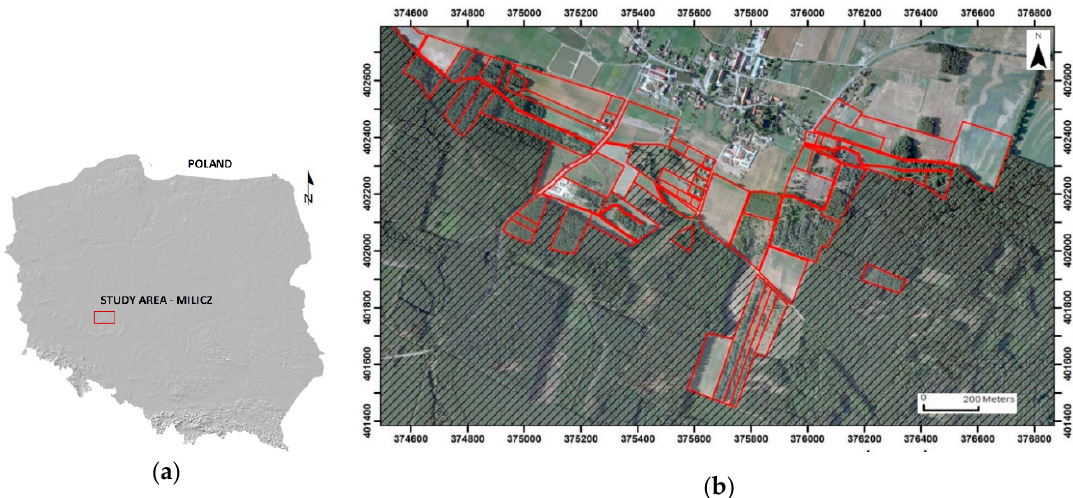
Figure 1. The study area: ( a ) general map of Poland with study area in Milicz District; ( b ) study area: analyzed plots—marked red, plots of the State Forests—hatched area (background: orthophoto map 2012; coordinates system: PL-1992).